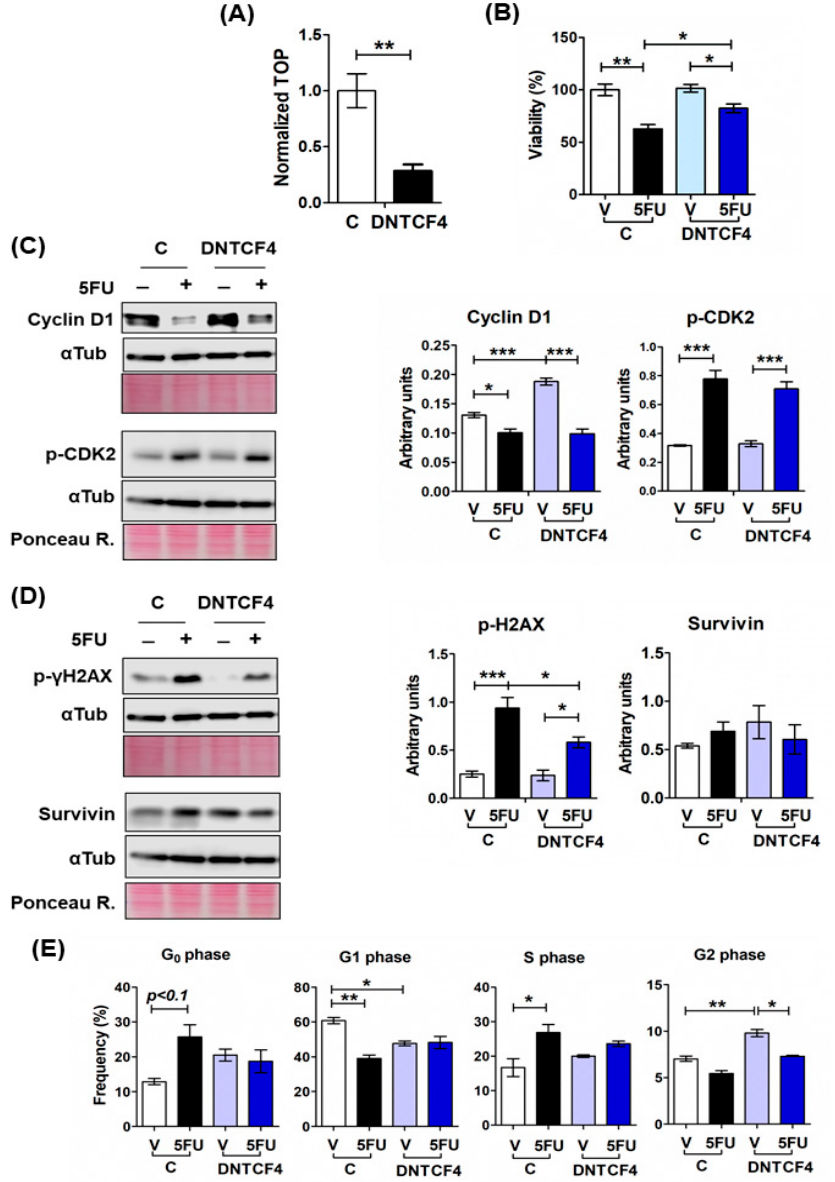
Figure 5. Dominant negative TCF4 (DNTCF4) promotes cell survival in SW620 Spheroids treated with 5FU through decreasing DNA damage. ( A ) β -catenin/TCF-mediated transcriptional activity decreased as a result of DNTCF4 expression in SW620 cells transfected with plasmid pPGS dnTcf- 4(deltaN41). The normalized activity of the TCF reporter (TOP-Luc) is shown. Renilla luciferase levels were used as transfection control. ( B ) SW620 spheroids that express dnTCF4 were treated with 5FU for 72 h. Cell viability was measured using the CellTiter Glo-3D Kit and compared to spheroids derived from cells transfected with an empty vector. ( C , D ) Immunoblot analysis of cyclin D1 ( C ), phospho-CDK2 (Th160) ( C ), phosphor-histone γ H2AX (Ser 139) as DNA damage marker, and survivin ( D ) in SW620 spheroids dnTCF4 and control spheroids treated with or without 5FU for 72